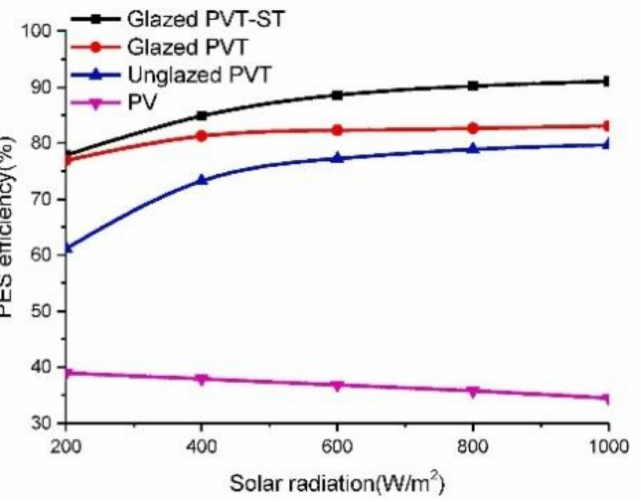
Figure 16. Primary energy savings of different systems (reprinted from [97], with permission from